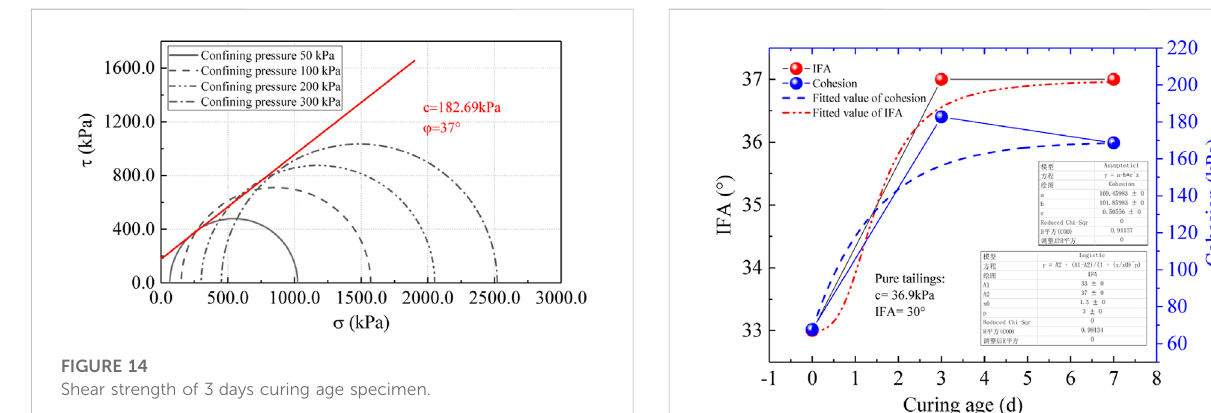
FIGURE 14 Shear strength of 3 days curing age specimen.